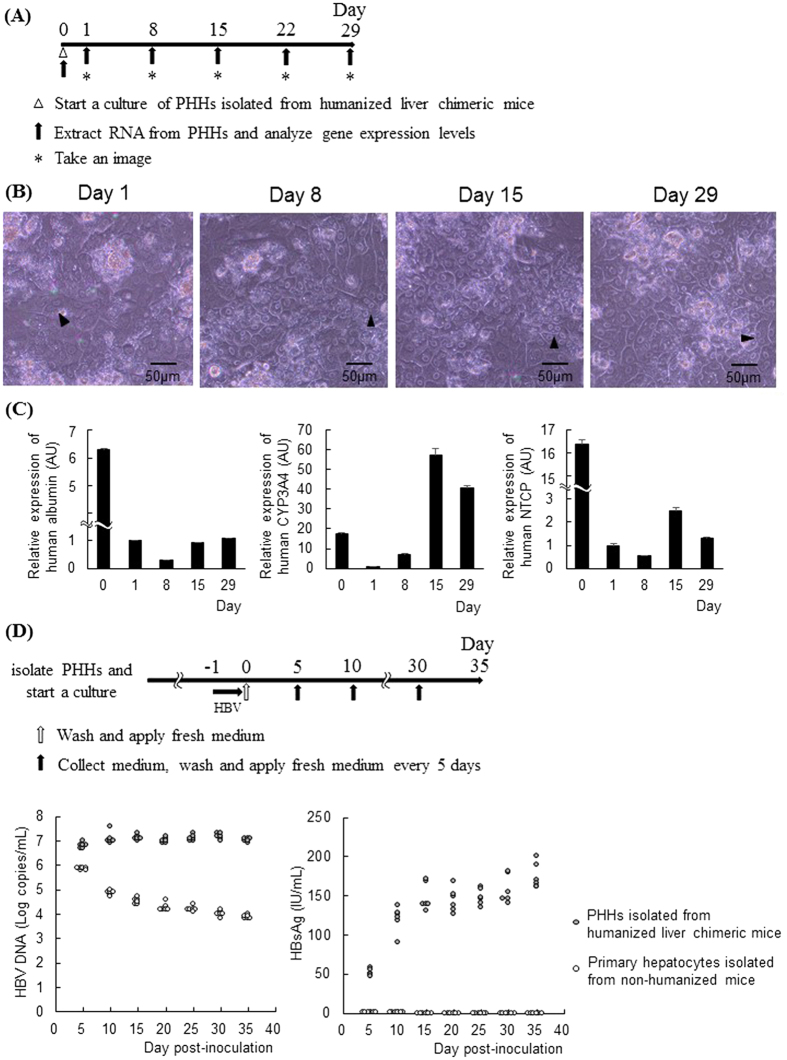
PHHs isolated from humanized liver chimeric mice were susceptible to HBV.(A–C) PHHs were isolated from humanized liver chimeric mice. Schematic of experimental procedure (A). Representative images of PHHs isolated from humanized liver chimeric mice at the indicated times (B). Arrowheads indicate cells with a diploid nucleus. Real-time RT-PCR analysis of gene expression levels at the indicated time (n = 4) (C). (D,E) PHHs were incubated with HBV inoculum at 500 GEq/cell for 24 hours. Schematic of experimental procedure (D). HBV DNA and HBsAg levels in culture media from PHHs isolated from humanized liver chimeric mice or non-humanized mice were quantified every 5 days after HBV inoculation (n = 6) (E). AU; arbitrary unit.